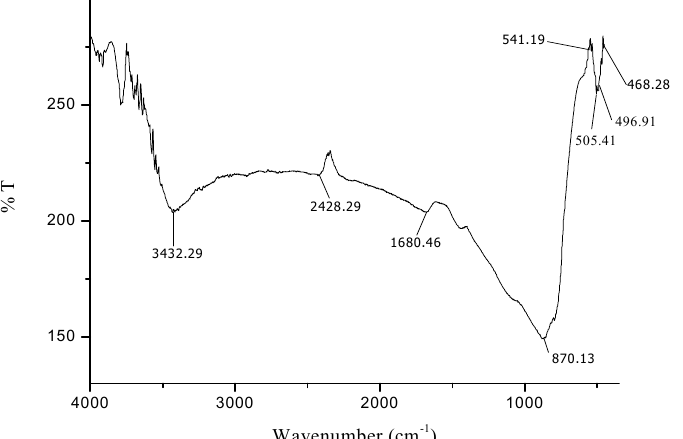
Figure 1. FTIR spectra of Neem leaf extract.